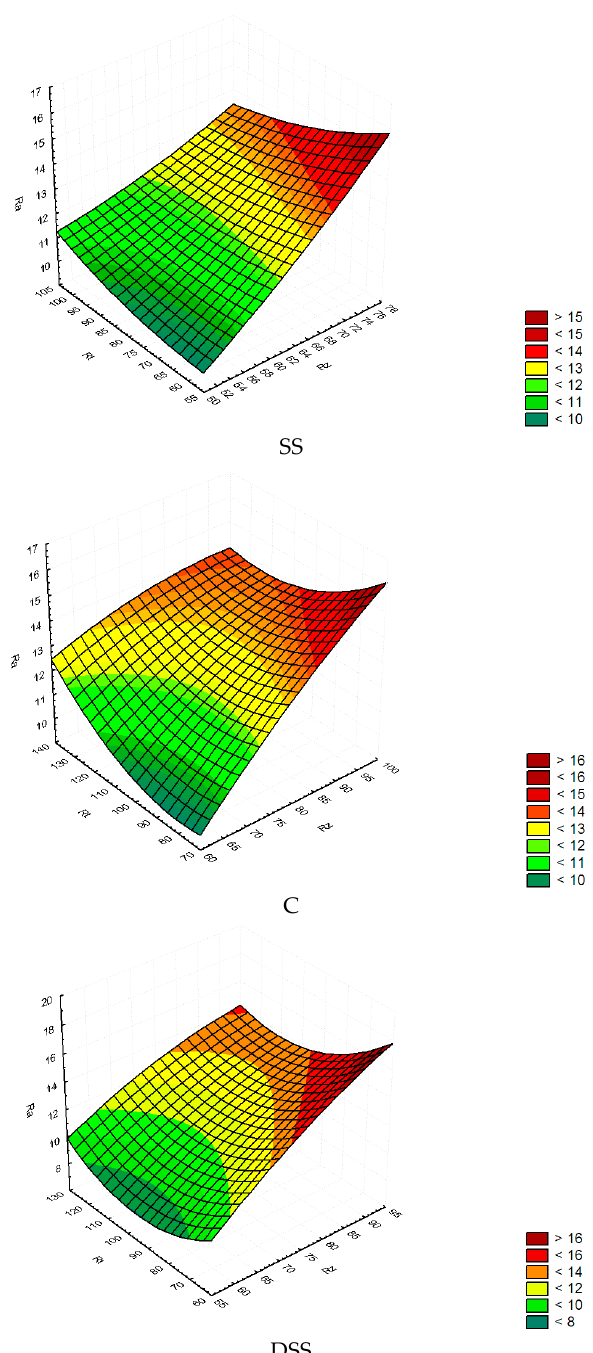
Figure 12. 3D models graphs of the blasting surfaces.